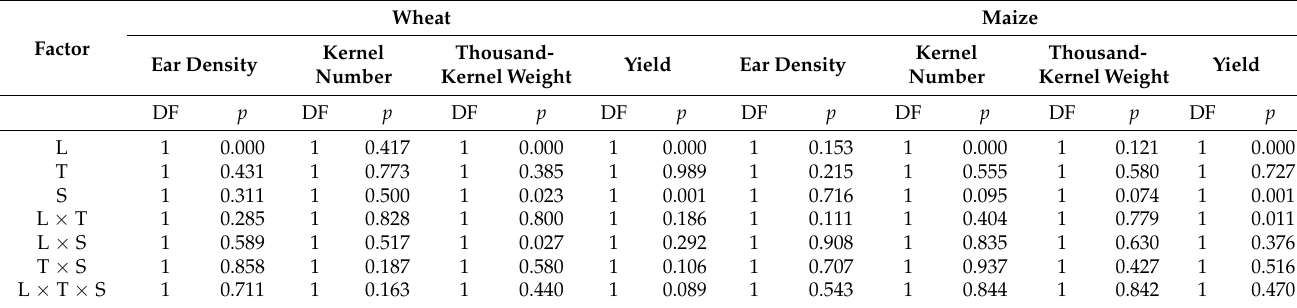
Table 3. Three-way analysis of variance of the effects of long-term experiments on crop yield and yield